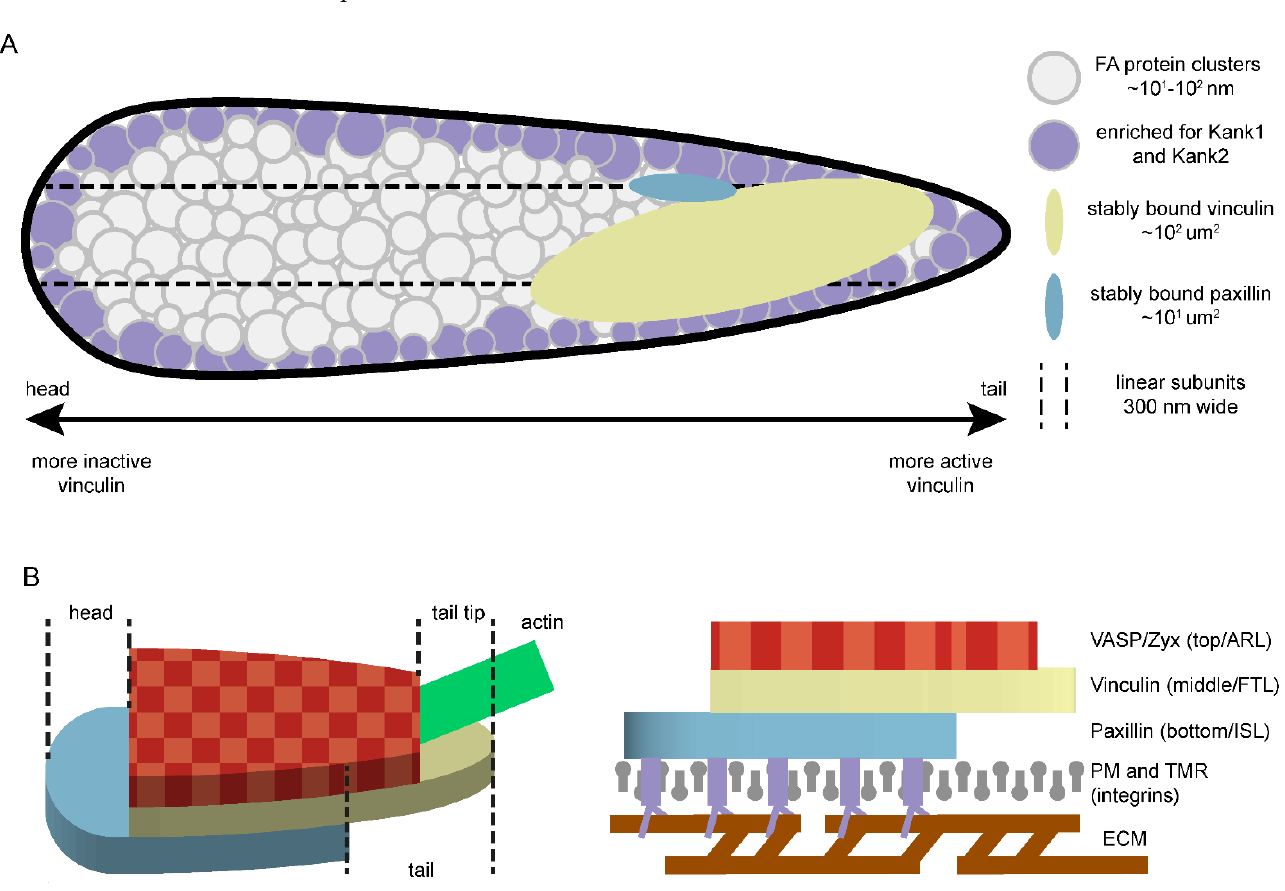
Figure 9. The nanoscale architecture of focal adhesions. ( A ) Schematic model of the nanoscale organisation of proteins within focal adhesions as seen from above. Head indicates the FA end closest to the edge of the ventral (adherent) portion of the plasma membrane. ( B ) Schematic side-view model of the nanoscale protein organisation within focal adhesions. PM is plasma membrane and TMR is transmembrane receptors.